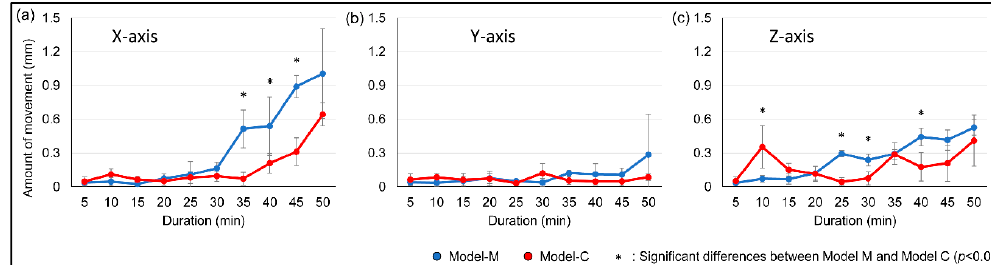
Figure 5. Average amount of tooth movement on the amount of 3D movement of the center of gravity (ACG). ( a ) X ‐ axis, ( b ) Y ‐ axis, ( c ) Z ‐ axis.